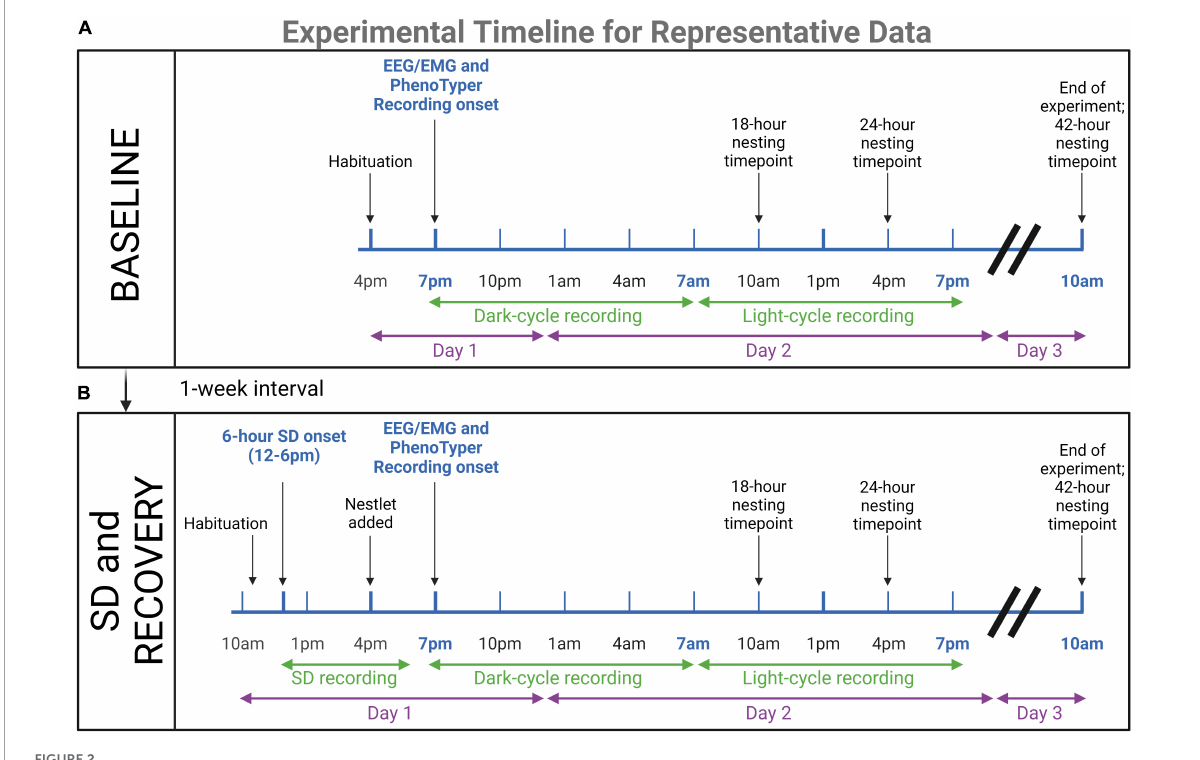
FIGURE2 Timeline for representative data experiments. Young ( n = 4) and aged ( n = 4) mice underwent EEG/EMG recordings in PhenoTyper home cages to assess dark and light cycle sleep patterns and nesting. (A) 24-h baseline recordings were conducted, with 3 h of habituation prior to recording onset at 7 p.m. At 10 a.m. on the third day, mice were removed from the cage and potentiostats were unplugged. Nesting timepoints were 18, 24, and 42 h. (B) One week later, mice were tested again in the same paradigm with the addition of a 6-h sleep disruption (SD) prior to the recording. This SD was conducted in the home cages with aversive stimuli. Mice were plugged into potentiostats and habituated 1-h before the onset of SD (12–6 p.m.). The nestlet was added at 4 p.m. to keep nesting time points consistent. The immediate recovery period